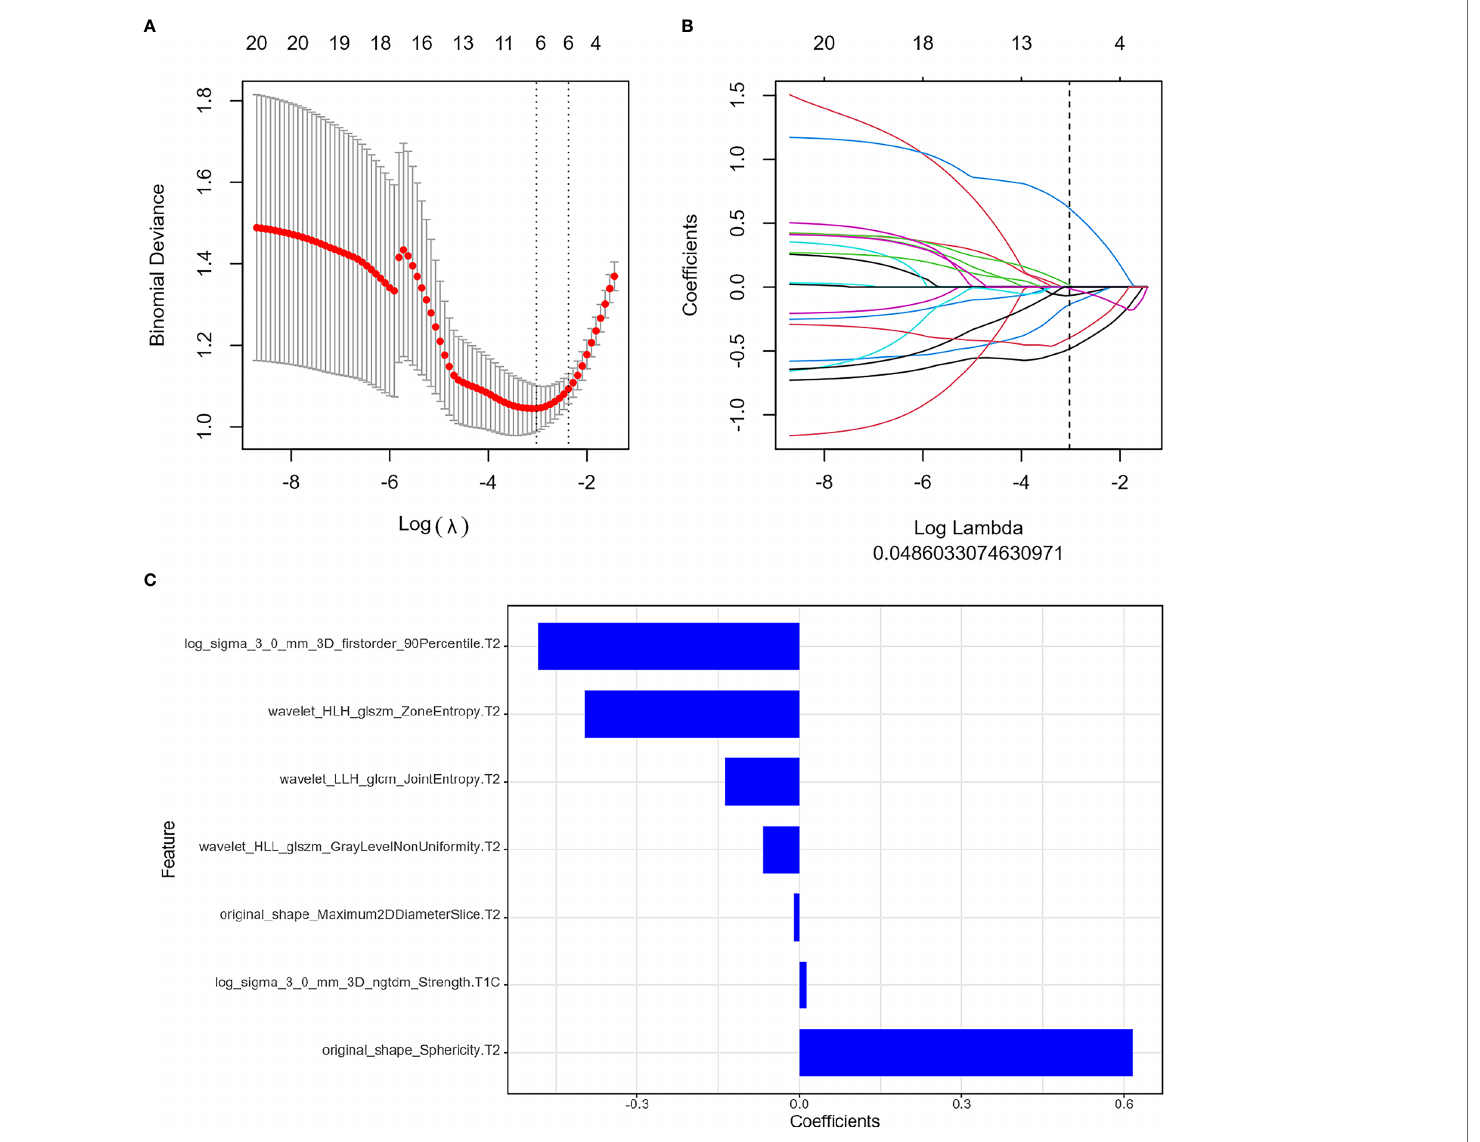
FIGURE 3 | Feature extraction before treatment. (A) Uses ten-fold cross-validation and minimum criteria to select the adjustment parameter ( l ). (B) LASSO coef fi cients of 20 texture features, drawing vertical lines at the selected optimal value in l sequence. (C) Screens seven features. LASSO, least absolute shrinkage and selection